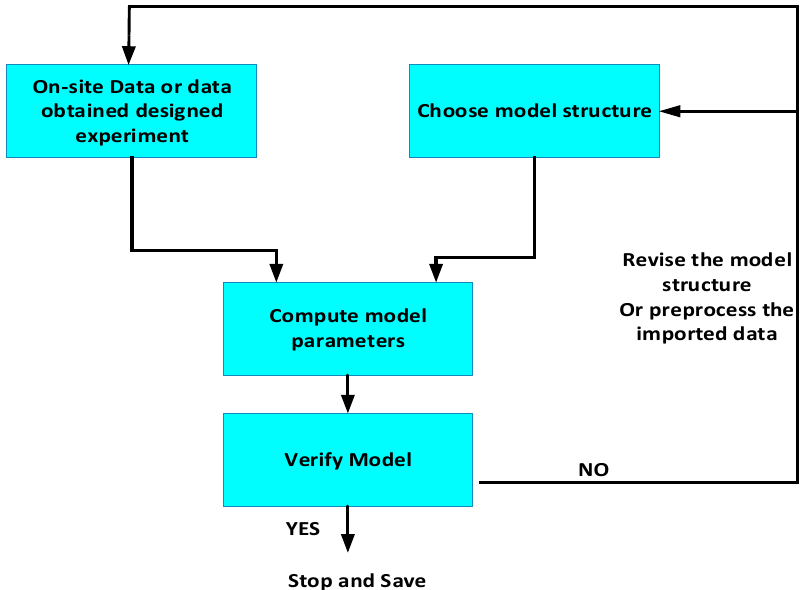
Figure 5. The empirical modeling procedure.